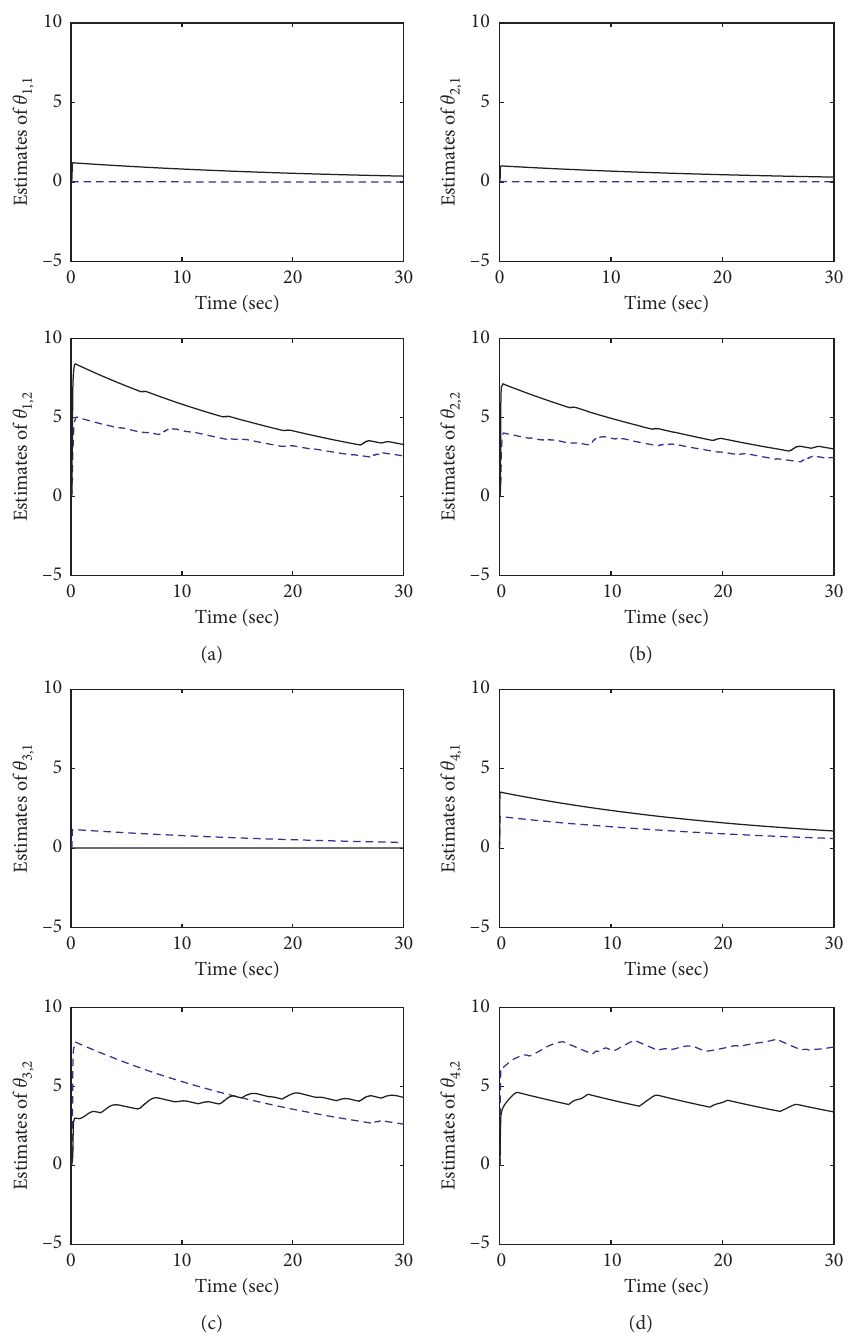
Figure 5: The adaptive laws of the four followers. (a) 􏽢 θ